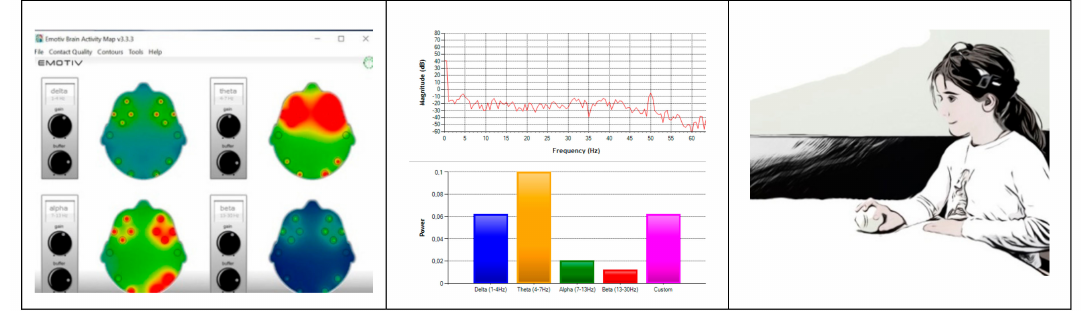
Figure 2. Examples of Emotiv Brain Activity Map and TestBench applications interfaces in conjunction with a video image simulation.